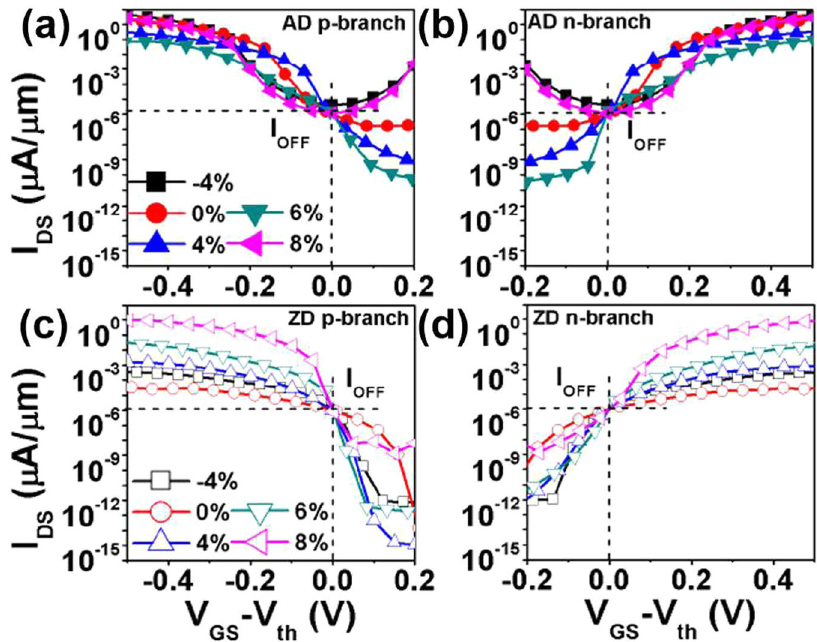
Fig. 17 Simulation Report of Nanoscale 2D Ph-TFET. Transfer characteristics of Ph-TFET for a p-type and b n-type operational mode in armchair direction, c p-type and d n-type operational mode in the zigzag direction, under applied uniaxial strain, adapted with permission from 103 . Copyright (2017) IEEE.